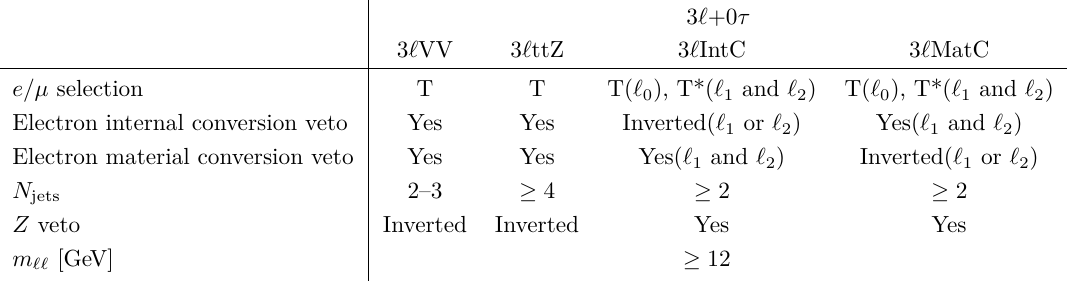
. Backgrounds T ). ee 3 ‘ +0 τ